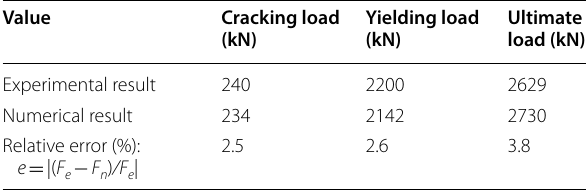
Table 3 Comparison of